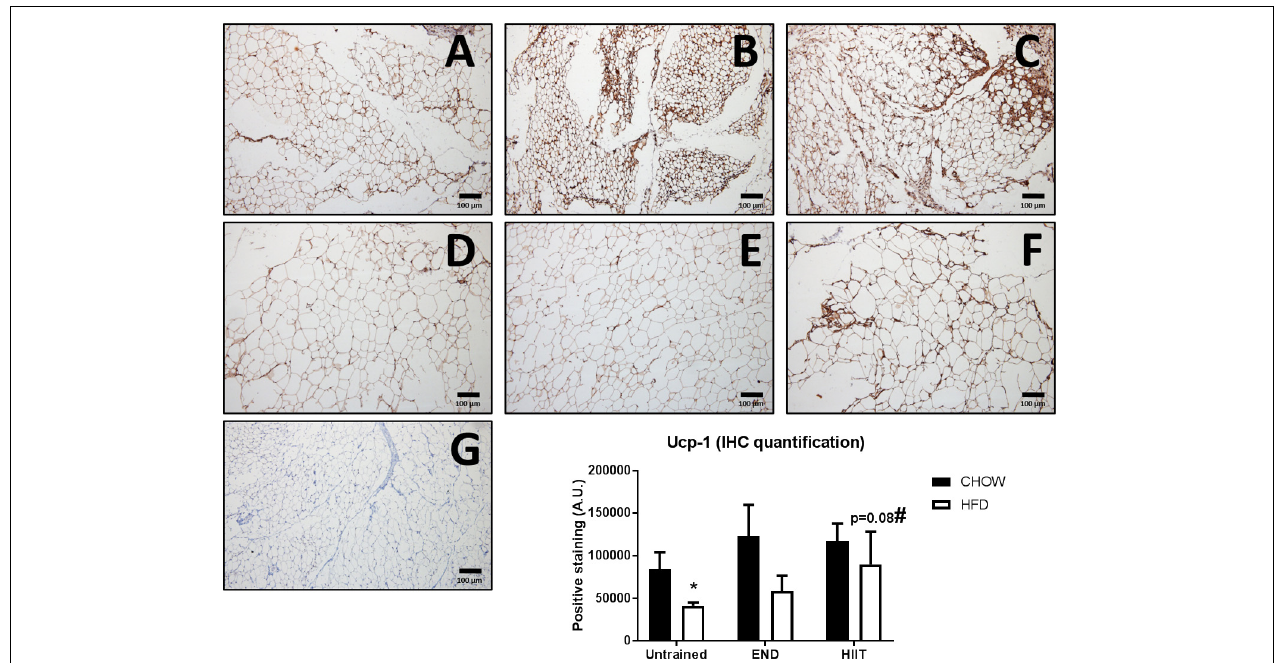
FIGURE 8 | Immunohistochemistry and quantification of subcutaneous adipose tissue uncoupling protein 1 (Ucp-1). Representative cross-sections of subcutaneous adipose tissue with uncoupling protein 1 immunohistochemistry determined by immunoperoxidase stain, and nuclear counter-staining with haematoxylin. CHOW untrained (A) , CHOW+END (B) , CHOW+HIIT (C) , HFD untrained (D) , HFD+END (E) , and HFD+HIIT (F) are displayed. HFD diet induces a decrease of positive staining, whereas HIIT normalize this change. A negative control without primary antibody is shown in (G) . The size bars indicate 100 µ m and images are at 10 × magnification. Quantification of positive staining is presented as means ± SEM and the number of animals in each group is 3. ∗ p < 0.05 vs. CHOW untrained; # p = 0.08 vs. HFD untrained by Two-way ANOVA with Tukey’s and Sidak’s post hoc tests.